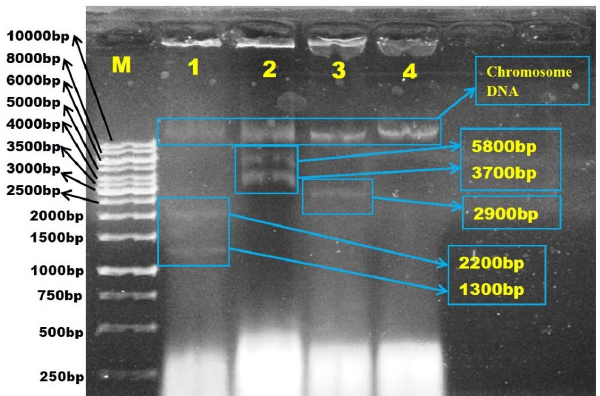
Figure 4. Multiple-antibiotic-resistance profile of E. coli from 6 Sarawak rivers and 3 aquaculture farms.